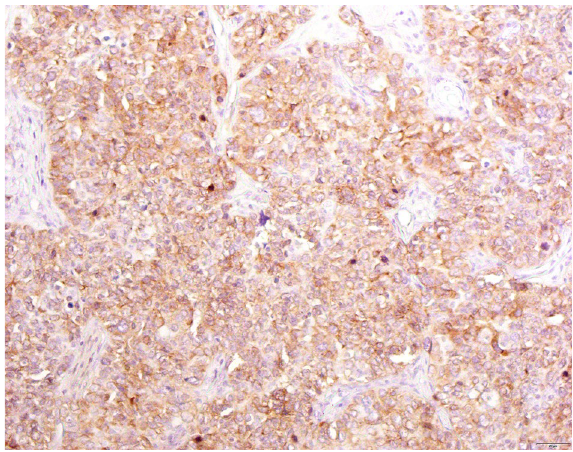
Figure 1. Immunohistochemical staining with IMP3 in patients with rectal cancer in clinical stage II. Positive cells display brown cytoplasmic